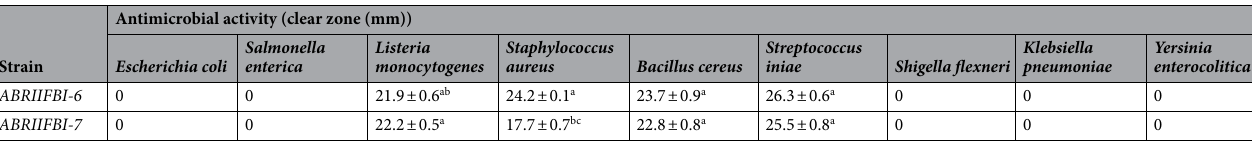
Table 2. Antimicrobial activity of isolates against the pathogenic bacteria. Values are mean ± standard deviation. Different lowercase superscript letters are significantly different (P ≤ 0.05). All experiments